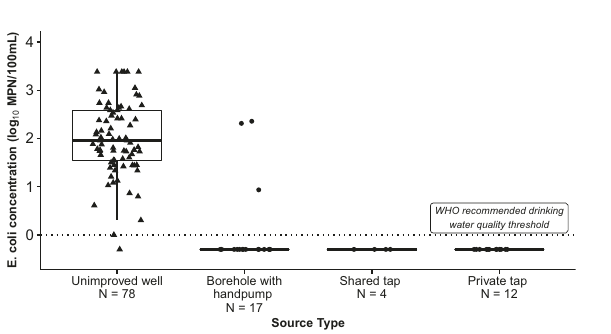
Fig. 2 Source water quality. Boxplot of E. coli concentration (log 10 MPN/100 mL) in source water samples by source type, combined across all study phases.